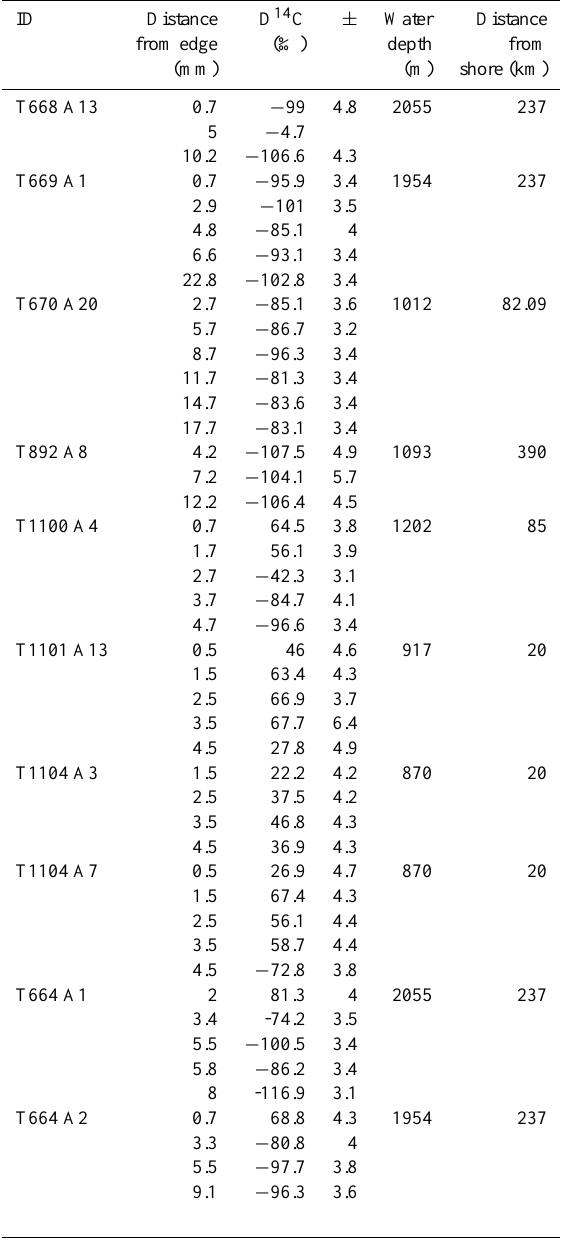
Table 2. Radiocarbon analyses on organic nodes presented in Fig.